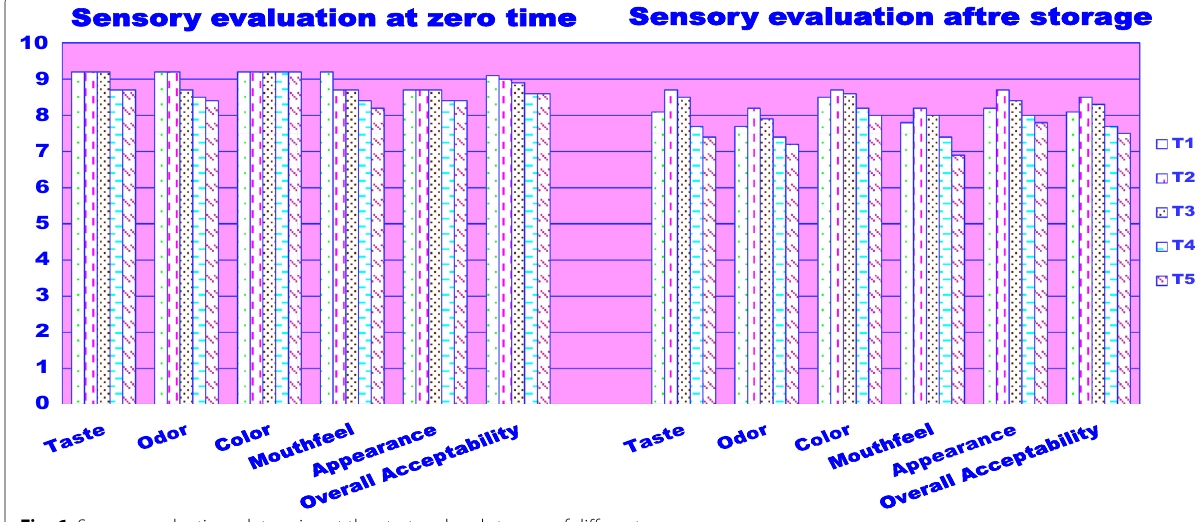
Fig. 6 Sensory evaluations determine at the start and end storage of different syrups